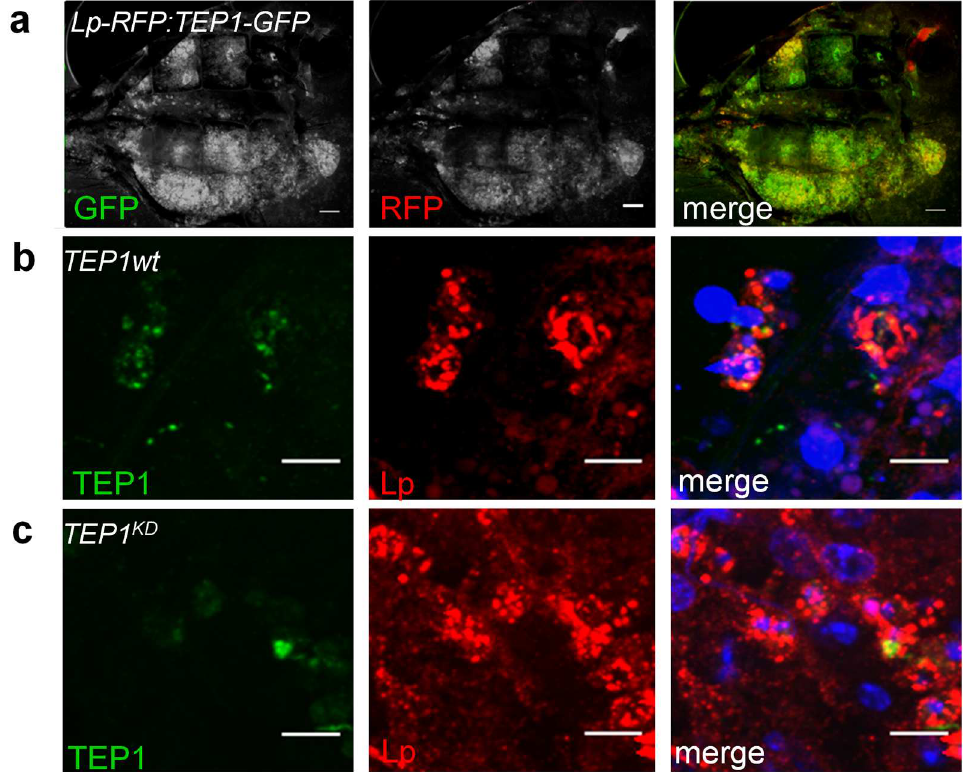
Fig 2. TEP1 expression in fat body cells. a. Dissectedcarcass of TEP1-GFP , 3xP3-RFP and Lp-RFP , 3xP3-CFP mosquitoexposingthe fat body that shows GFP and RFP expression. Merged image shows co- expressionof Lp and TEP1 reporters in the fat body. Scale bar = 200 μ m. b-c. Stained carcasses of wild type ( b ) and mosquitoes treated with dsTEP1 ( TEP1KD ( c )) showingTEP1 antibody staining(green) in Lp-expressing fat body cells. Note reductionin TEP1 stainingin TEP1KD carcasses. Dapi stained cell nuclei (blue). Shown are z-projections of confocal images, scale bar = 10 μ m. Images were collectedon a Zeiss LSM 710 confocal